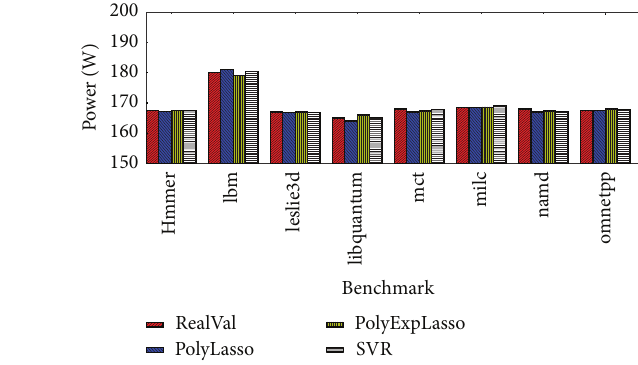
Figure 2: Result comparison on training data.